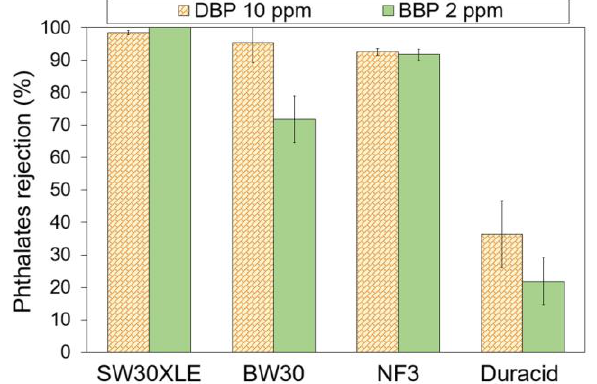
Figure 5. Phthalates rejection by different RO and NF membranes at ~pH 6.30.